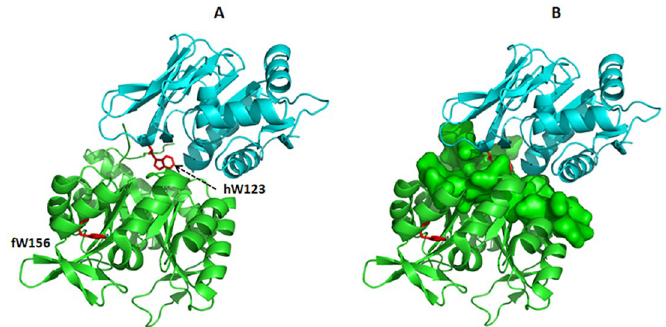
Fig 1. Interface of the HisF-HisH heterodimer showing the buried residue hW123. HisH is shown in cyan and HisF in green. A) Structure of the HisF-HisH heterodimer (PDB 1GPW) evidencing a single tryptophan residue (hW123 and fW156; in red) in both proteins. B) HisH has an exposed tryptophan residue (hW123) that is buried in the molecular surface of HisF residues in the heterodimer interface (green). Structures were visualized using Pymol